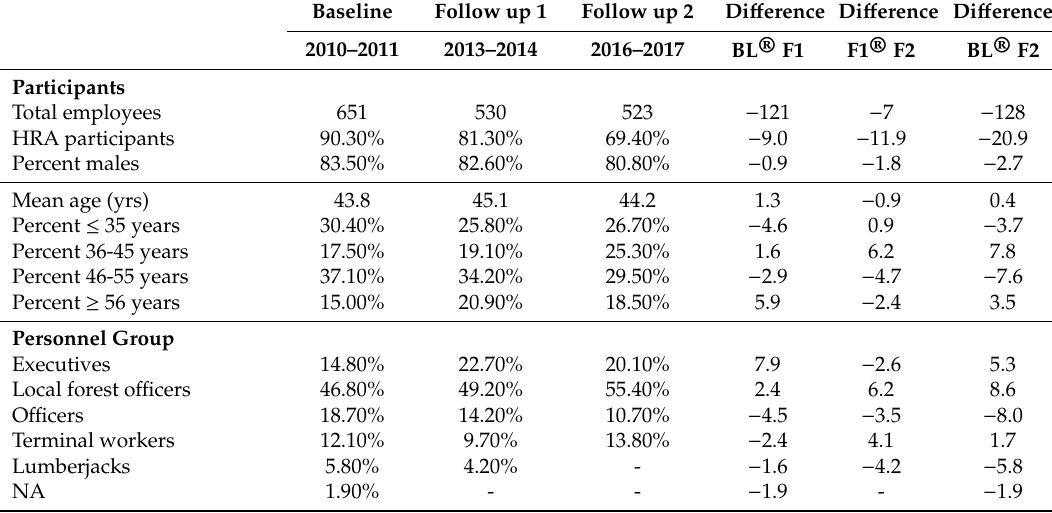
Table 2. Health Risk Trends at Three Di ff erent Time